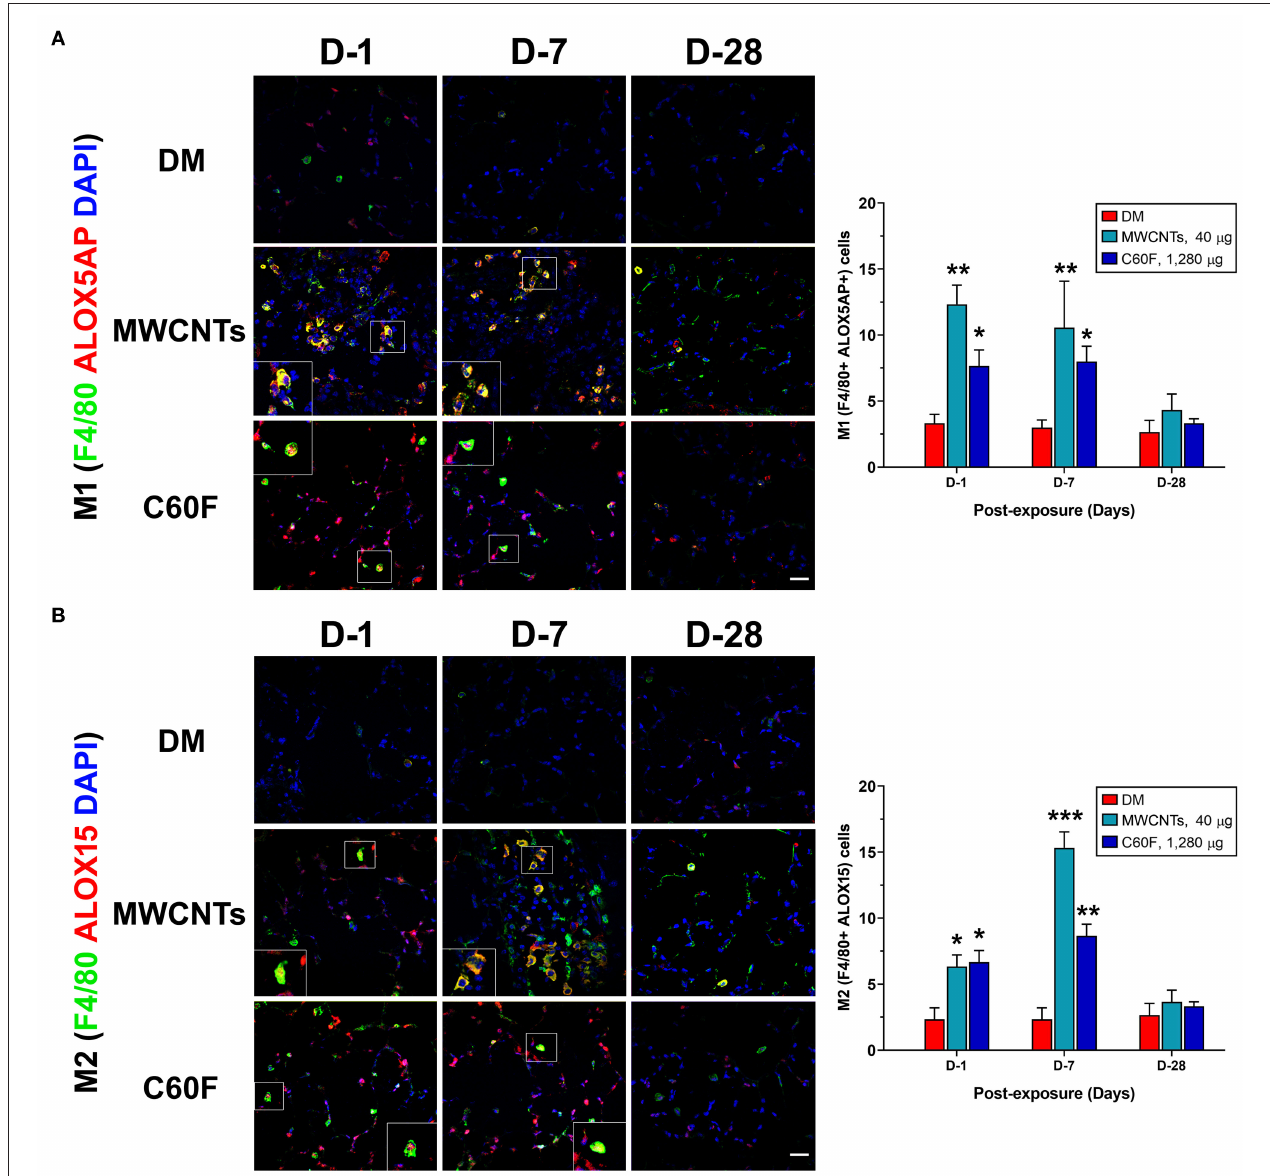
FIGURE 10 | Macrophage polarization and lipid mediator pathway induction in mouse lungs exposed to MWCNTs or C60F. Mice were treated as described in Figure 2 legend and the lungs were examined. Macrophage polarization and lipid mediator pathway induction were examined by double immunofluorescence staining with anti-F4/80 (green) and anti-ALOX5AP (red) antibodies (A) , or anti-F4/80 (green) and anti-ALOX15 (red) antibodies (B) . Numbers of representative double positive cells per 100 cells were counted from captured images and shown as mean ± SEM ( n = 3). Scale bar = 20 µ m. * p < 0.05; ** p < 0.01; *** p <